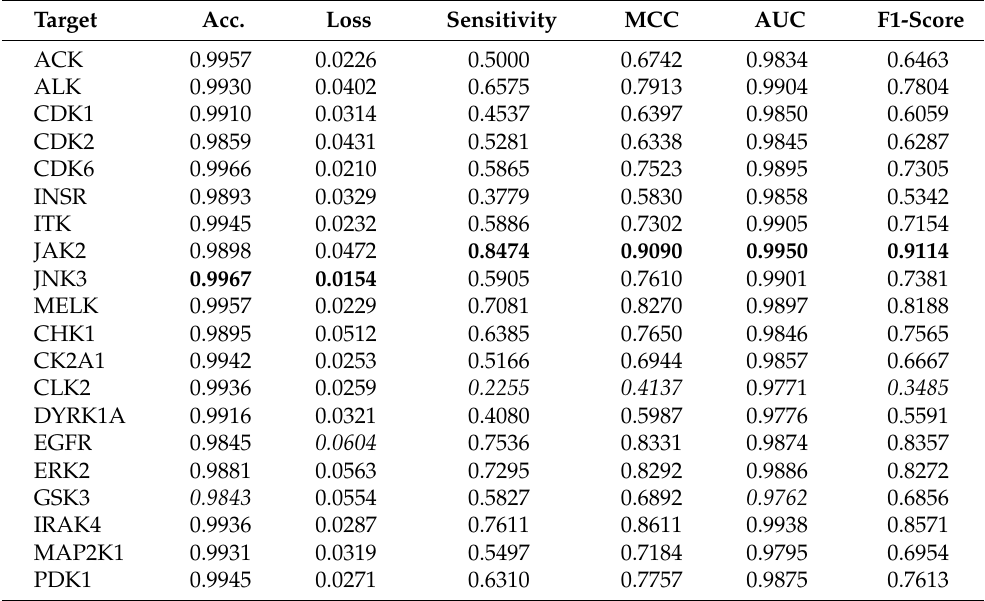
Table 1. Accuracy metrics for all the targets. Best/worst values for each column are in